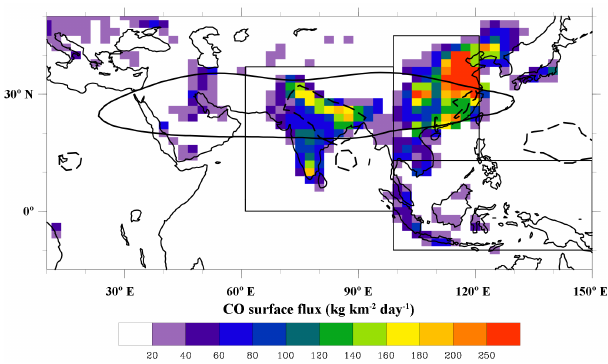
Figure 10. Anthropogenic emissions of CO from the Streets 2006 inventory for July. The black dashed line is the 2.5kgm − 2 s − 1 con- vective upward mass flux contour at 2225hPa from GEOS-5 for July 2009 and the solid black line is the 12520m GH contour from MERRA at 200hPa for July 2009. The three boxes correspond to the regions selected for the sensitivity simulations with anthro- pogenic emissions switched off (South, East and Southeast